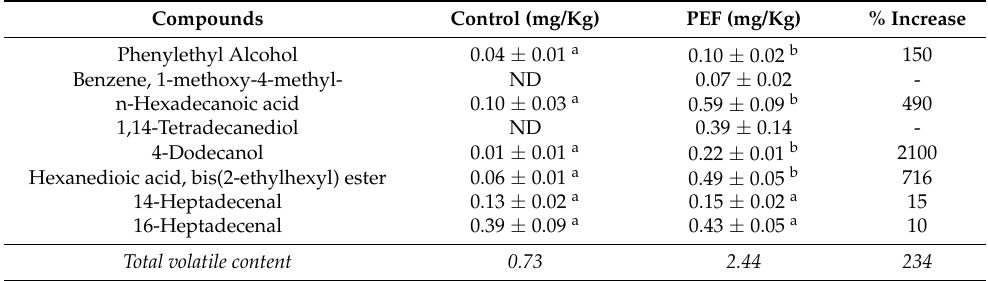
Figure 1. Representative chromatograms of grape stem extracts obtained by ultrasound-assisted extraction (blue chromatogram) and obtained by ultrasound-assisted extraction, accompanied by a PEF pretreatment step (black chromatogram). Table 2. Volatile compounds detected by gas chromatography–mass spectrometry in PEF treated and non-treated samples. Statistically significant differences ( p < 0.05) are denoted with superscript